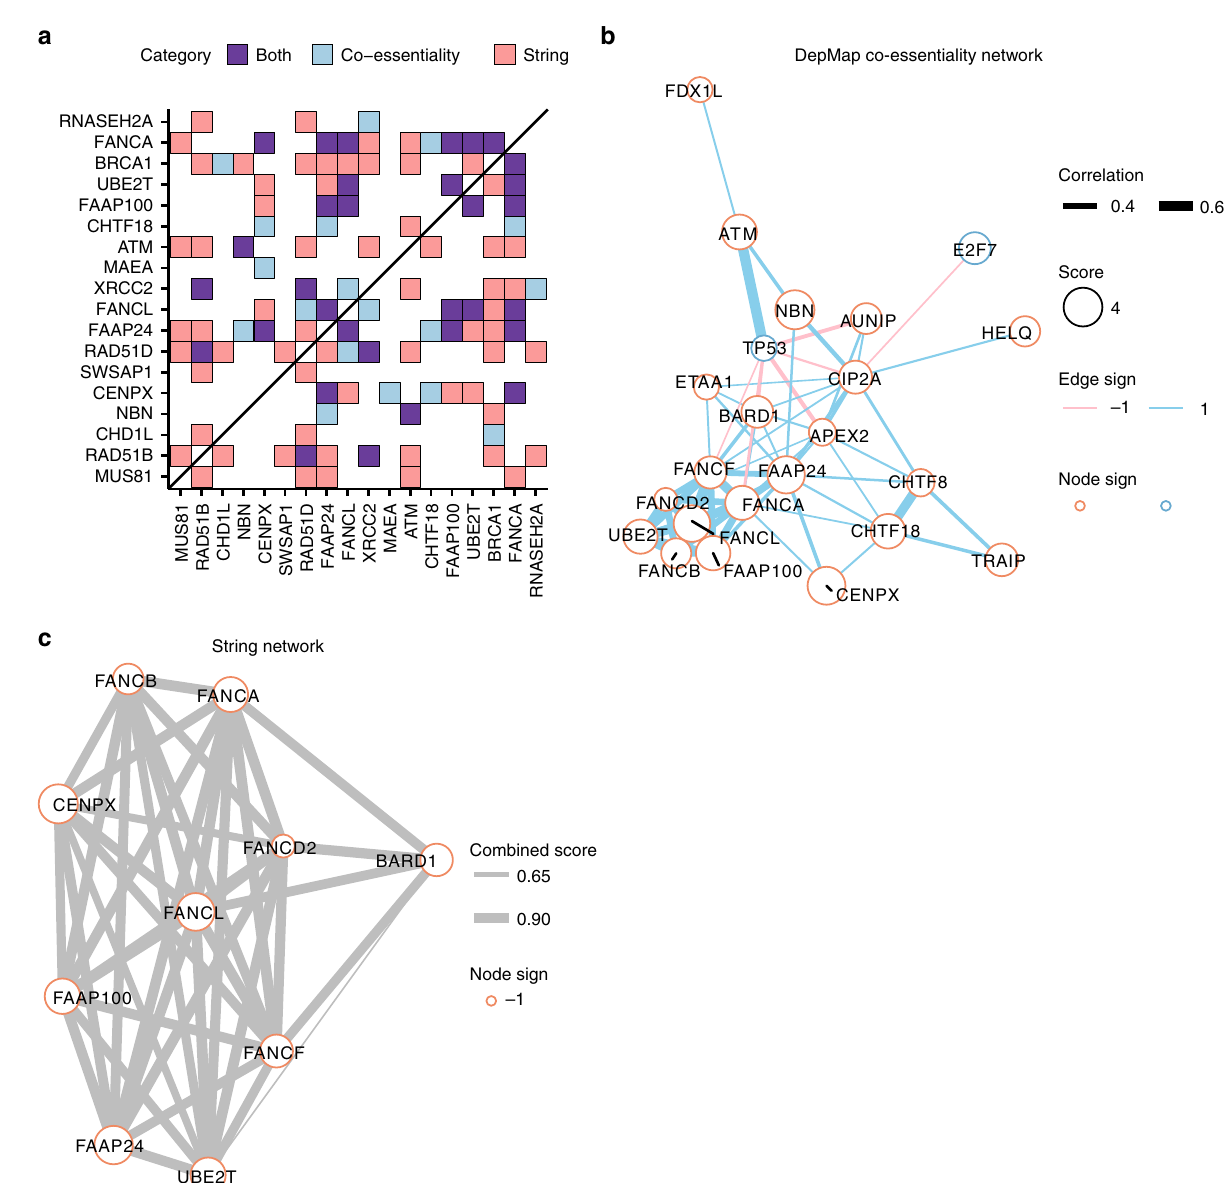
Fig. 7 PARP screens reveal functionally coherent clusters of genes. a Interactions between the top 20 gene hits, ranked by absolute Z -score, from DepMap co-essentiality and STRING network sources. Edges are drawn between genes with an absolute correlation greater than 0.2 or a STRING combined score greater than 0.4. Genes are ordered by absolute average Z -score. b Cluster with Fanconi anemia genes from the DepMap co-essentiality network. Nodes represent genes and the size of each node is proportional to its average Z -score across all screens. Genes with an absolute average Z -score greater than 2 across PARP1 conditions are included in the network. Edges represent Pearson correlations across co-essenitiality pro fi les in DepMap. Clustering was done by modularity optimization and a single cluster was chosen for visualization. c Cluster with Fanconi anemia genes in the STRING network. Nodes are the same as b . Edges represent combined score in STRING. Edges are drawn between genes with a STRING combined score greater than 0.4. Clustering was done the same as a